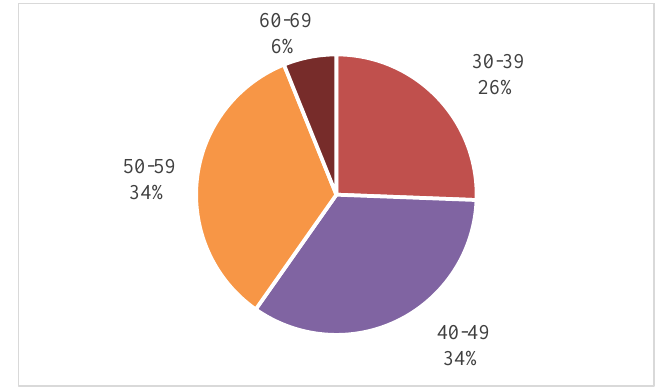
Fig. 1. The distribution of respondents by age (number of persons, %,